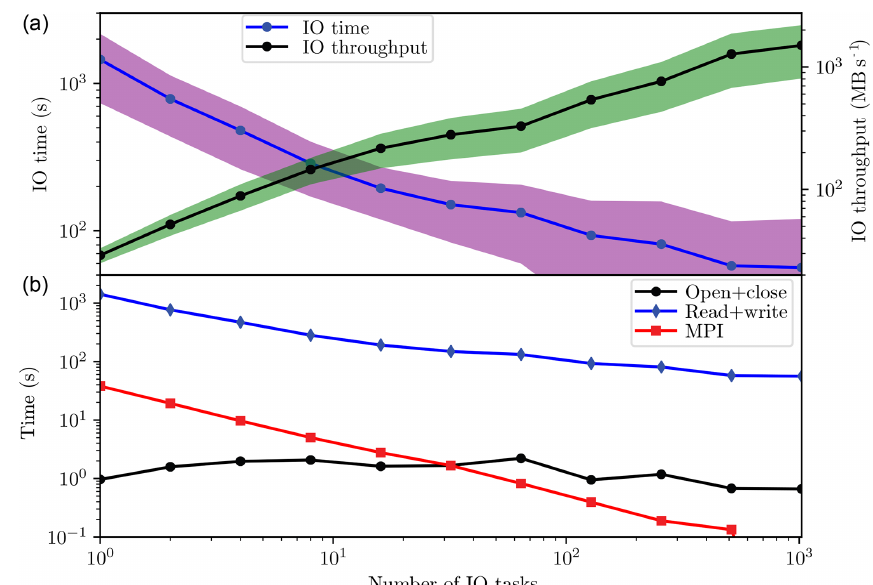
Figure 8. In the upper panel, the IO time (blue line) and throughput (black line) vary as a function of the number of IO tasks for reading and writing 40 restart files with 1024 MPI tasks using the proposed IO algorithm illustrated in Fig. 6. The shadings indicate the ranges between plus and minus 1 standard deviation. The size of each restart file is about 5GB. In the lower panel, the IO time in the upper panel is decomposed into the time for opening and closing (black line), the time for reading and writing (blue line), and the MPI communication time (red